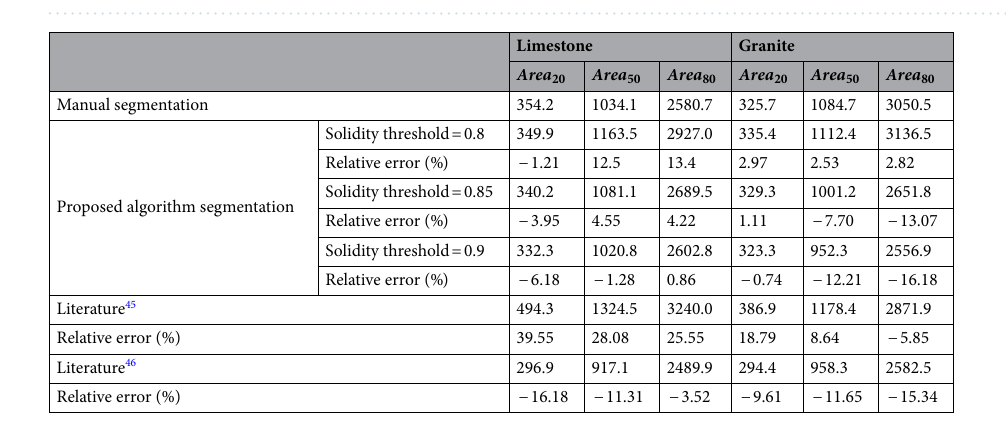
Figure 20. Cumulative area distribution curve.